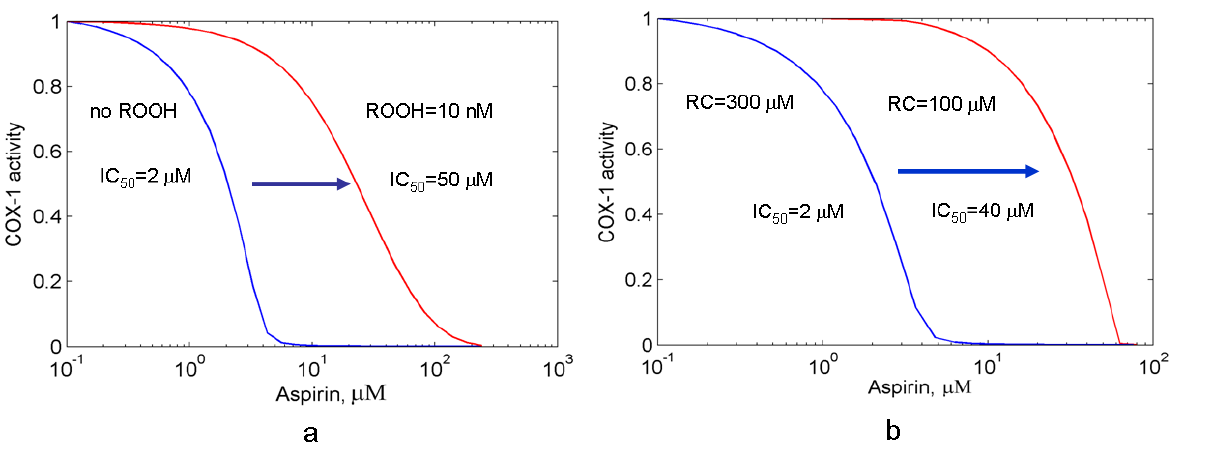
Figure 5. (a) The dose dependencies for aspirin calculated for PGHS-1 at the absence (blue line) and presence (red line) of external peroxide, ROOH; (b) The dose-dependences for aspirin calculated at the different cosubstrate (phenol) concentrations: 300 µ M (blue